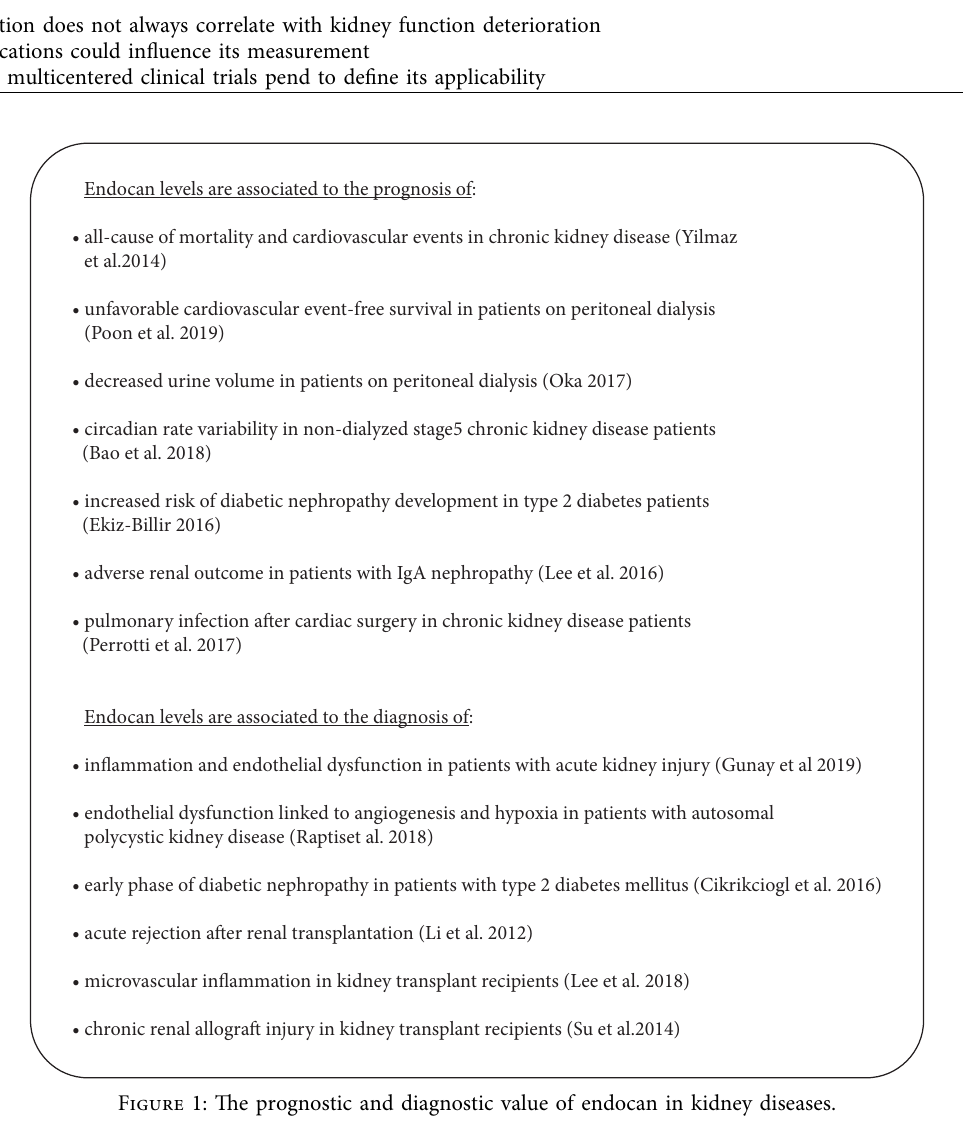
Benefits Soluble in human fluids Having low concentration in physiological conditions Easily measurable Noninvasive Multifunctional, associated with inflammation, endothelial injury, the decline of renal function, and/or incidence of cardiovascular events in several types of kidney disease Limitations